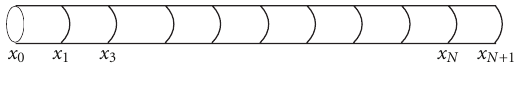
Figure 4: The thin wire is divided into N